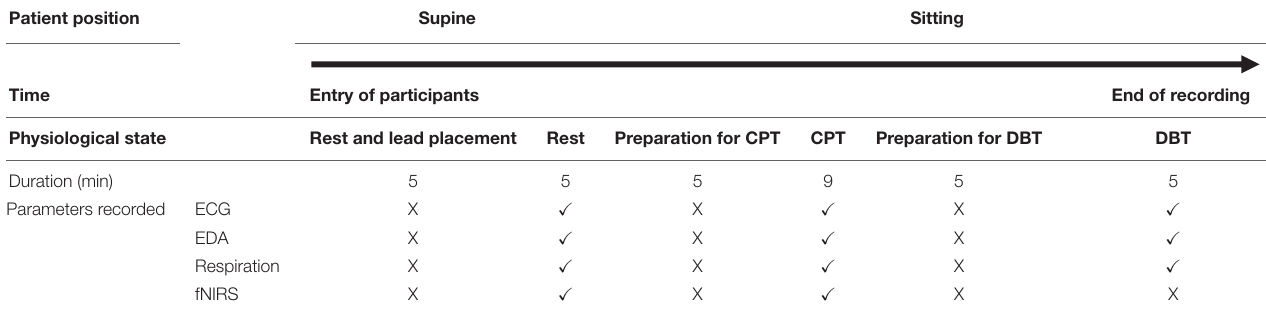
TABLE 1 | Physiological tests done during different conditions in the methodology. Patient position Supine Sitting